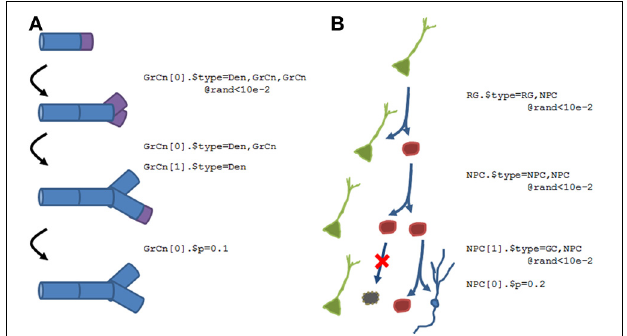
FIGURE 10 | Examples of how structural plasticity would be expressed within N2A. (A) Growing dendrite with growth cones. Progressive series of growth cone (GrCn) branching, differentiation, and death can lead to the construction of a complex arborization. Each step of this process could be regulated by other variables, such as external chemical signals or intrinsic activity. (B) Proliferation and Differentiation from a stem cell population. A radial glial cell (RG, green) can divide asymmetrically, producing a copy of itself and a neural progenitor cell (NPC, red). This NPC can then itself divide symmetrically, asymmetrically, differentiate, or die. As with the growing dendrite, each of these events can simply be probabilistic or regulated by other